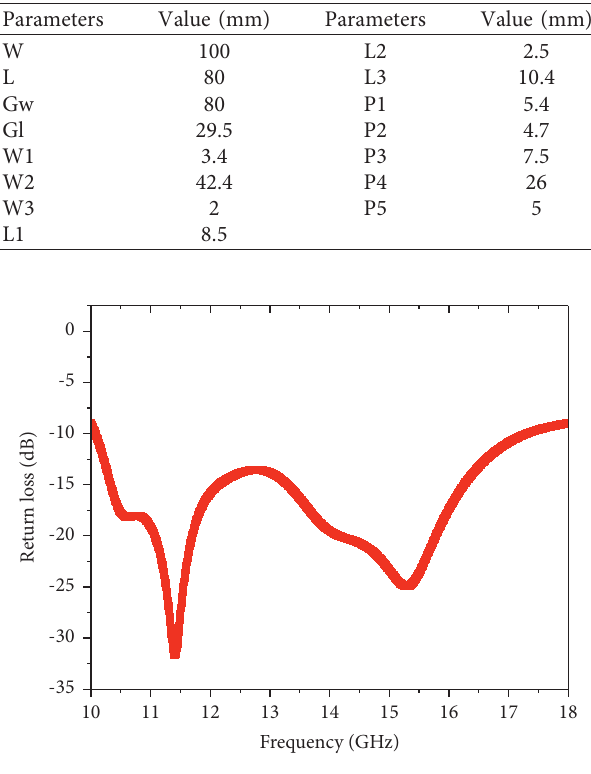
Table 2: Proposed array antenna parameters.